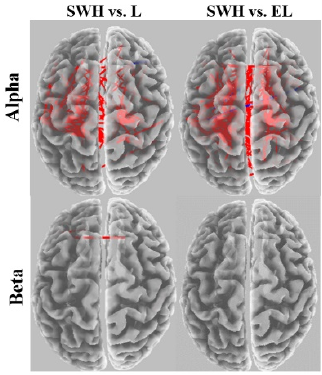
Figure 11. eLORETA wire diagram comparing somewhat hard exertion with other exertion levels for each frequency band. EL: extremely light, L: light, and SWH: somewhat hard.